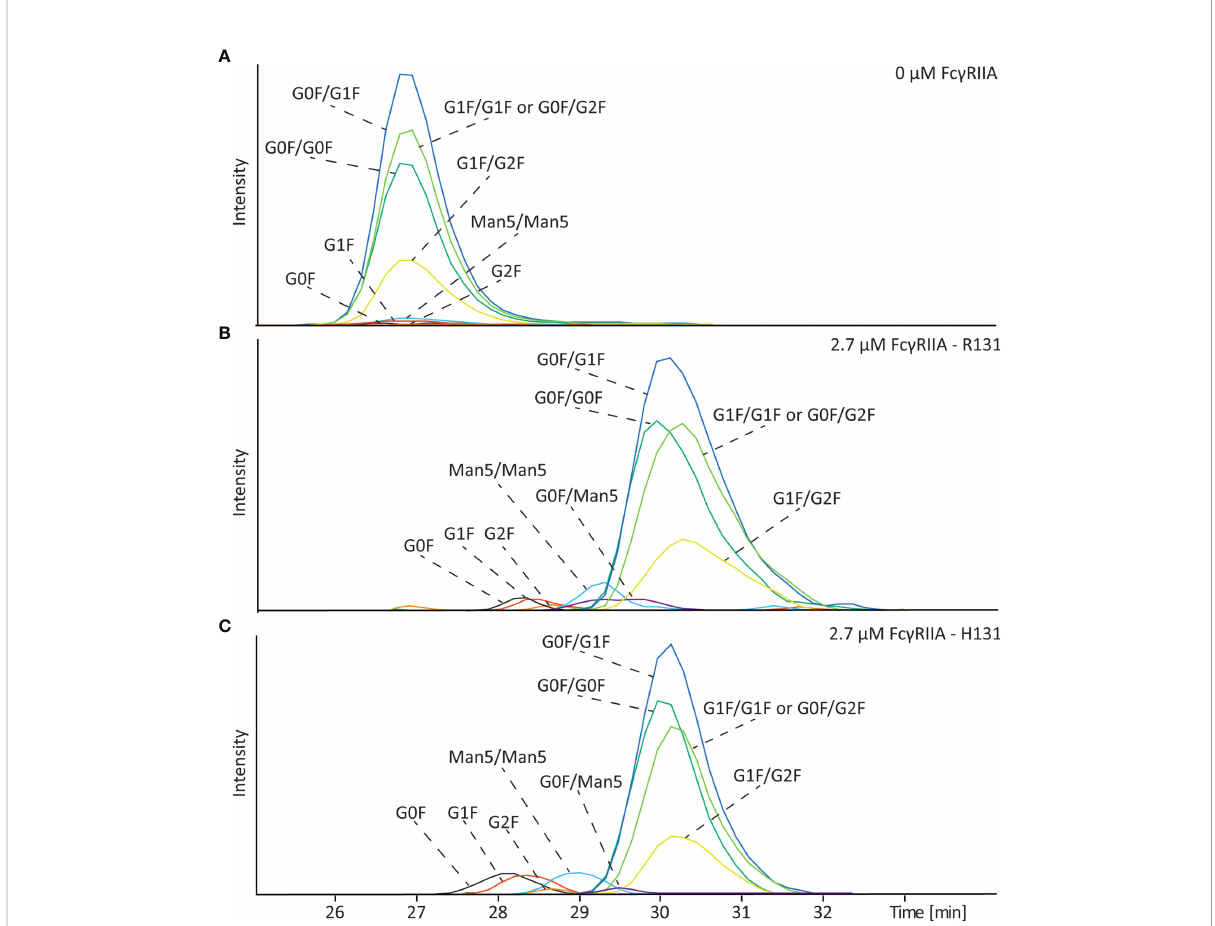
FIGURE 5 Af fi nity CE-MS analysis of mAb-D (wildtype) with (A) 0 µM Fc g RIIa or (B) with 2.7 µM of the R131 variant and (C) 2.7 µM of the H131 variant of the Fc g RIIa receptor. Shown are extracted ion electropherograms of the glycoforms observed in the antibody